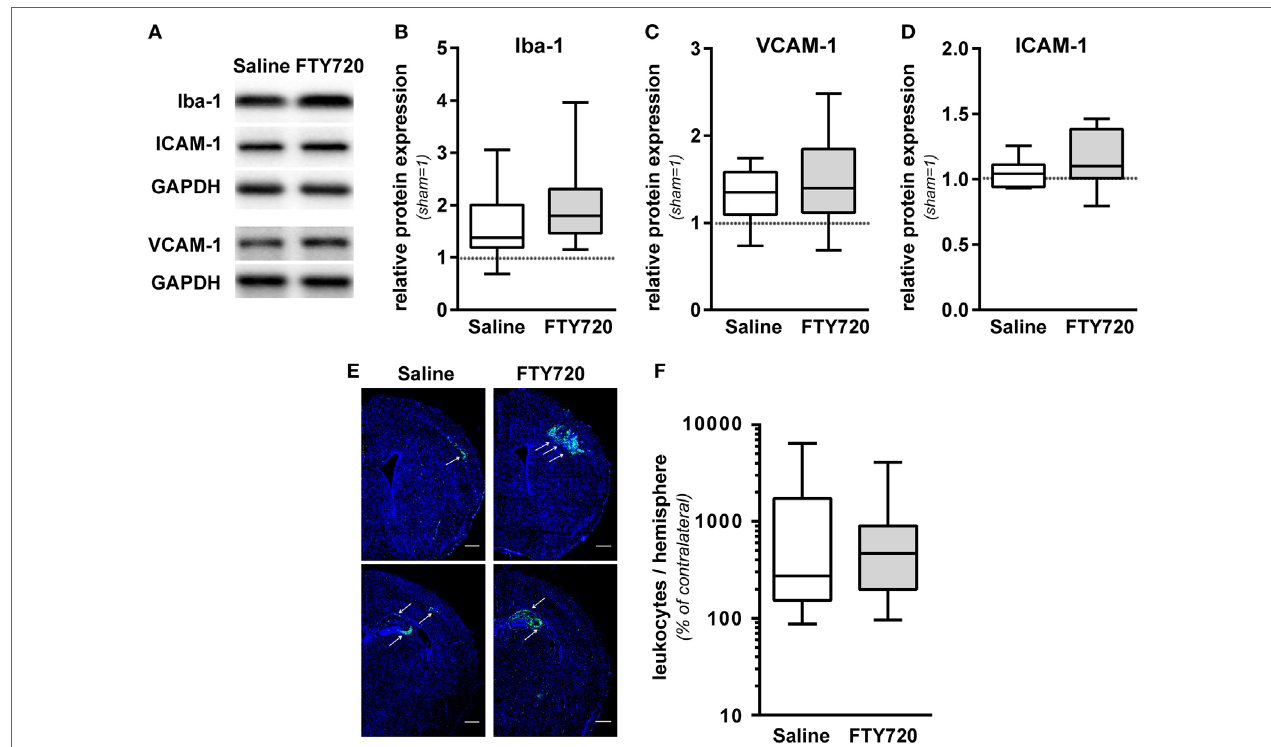
FigUre 4 | FTY720 does not alter microglia and endothelial activation and total leukocyte infiltration. P9 mice were exposed to HI followed by a single intraperitoneal injection of 1 mg/kg FTY720 or 0.9% NaCl (saline). (a) On P16 microglia and endothelial activation was assessed by quantification of Iba-1 (B) , VCAM-1 (c) , and ICAM-1 (D) in protein lysates via western blot. Protein lysates were prepared from ipsilateral hemispheres at the hippocampal level ( − 2.0 to − 2.3 mm from bregma) from brain sections of 200 µm thickness followed by gradient sodiumdodecylsulphate (SDS) electrophoresis (Iba-1 and ICAM-1) or protein separation in 12.5% SDS gels. After protein transfer, membranes were incubated with appropriate antibodies. Data were normalized to the reference protein glutaraldehyde-3-phosphate dehydrogenase (GAPDH) and sham controls. FTY720 treatment did not significantly alter Iba-1, VCAM-1, and ICAM-1 protein levels. (e) Leukocyte infiltration was evaluated qualitatively by immunohistochemistry for CD45 (green) 1 week after HI. Nuclei were counterstained with Dapi (blue). Representative images show maximal intensity projections of confocal z-stacks at the level of striatum and at the level of the hippocampus (scale bar: 500 µm). Leukocyte infiltration was most prominent in regions mainly affected by the detrimental effect of FTY720, e.g., the hippocampus and cortex (indicated by arrows) (e) . Quantification of leukocyte infiltration was performed by flow cytometry after isolation of single cell suspensions and myelin removal via Percoll gradient centrifugation (F) . Absolute cell counts of viable CD45 high cells were determined in contralateral and ipsilateral hemispheres using TrueCount beads. Numbers in ipsilateral hemispheres were related to contralateral hemispheres of the same animals to correct for inter-experimental variations due to isolation procedures. Two hemispheres were pooled per sample. Total HI-induced peripheral leukocyte infiltration was not significantly changed by FTY720. n = 14/group for (a–D) , n = 30–31 samples/group [pooled analysis from measurements for panel 1/lymphoid, panel 2/regulatory T cells ( Figure 5a ), and panel 3/myeloid ( Figure 5B )] for (e)